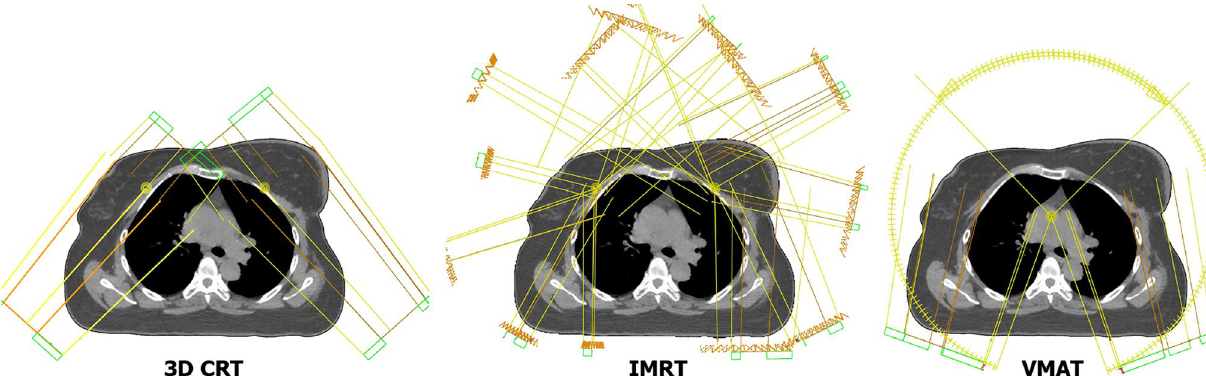
Fig. 1 An example of fields positioning for 3D CRT, IMRT and VMAT treatment plans Table 2 Comparison of PTV dose coverage characteristics using 3D CRT (1), IMRT (2), and VMAT (3)